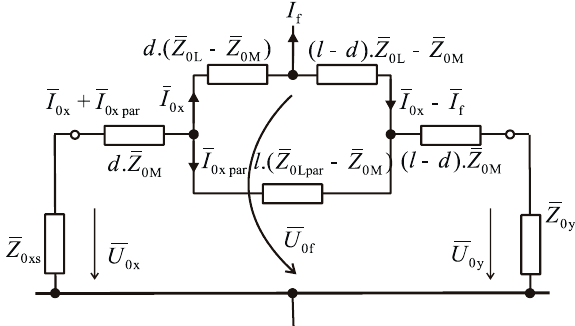
Figure 3. A zero-sequence component equivalent circuit for parallel-operated transmission lines.